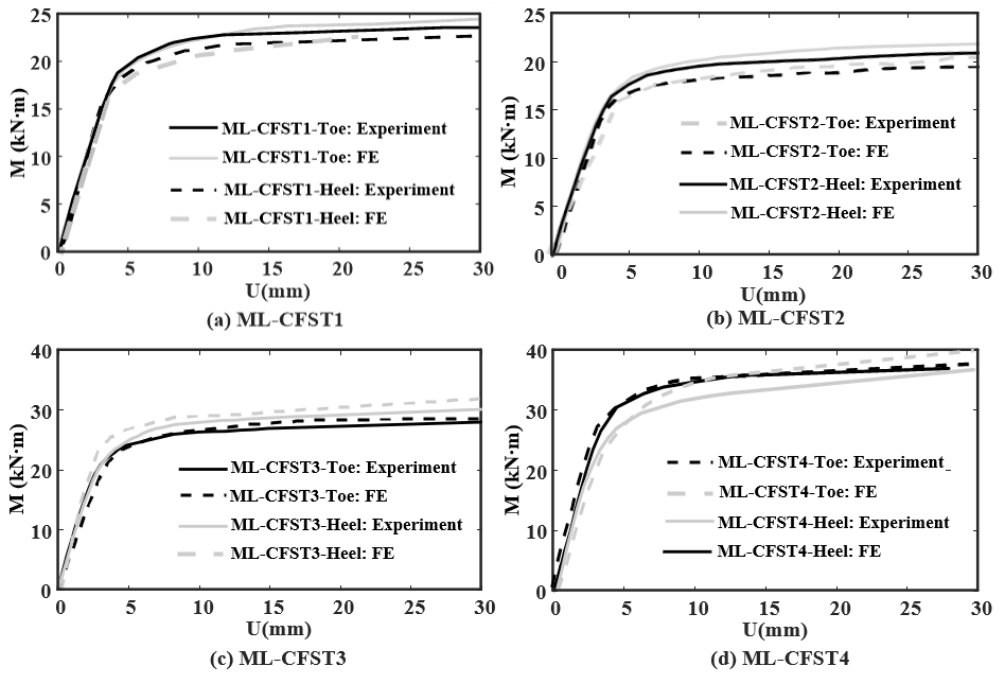
Figure 7. Comparison of moment–deflection curves from FE models against test results for ML-CFST beams: ( a ) ML-CFST1; ( b ) ML-CFST2; ( c ) ML-CFST3; ( d ) ML-CFST4.